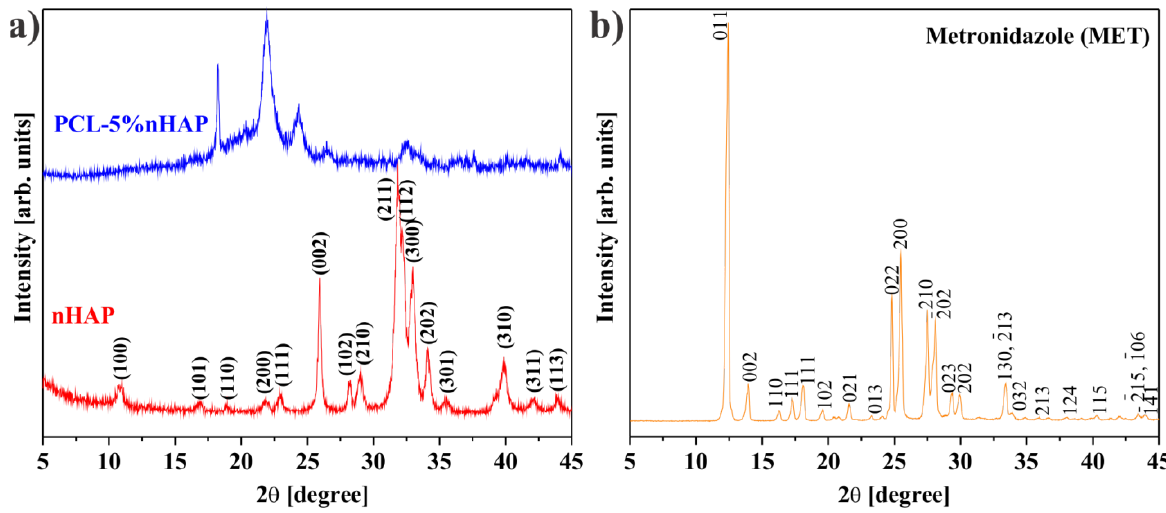
Figure 1. XRD patterns for ( a ) nano-hydroxyapatite (nHAP) and ( b ) metronidazole (MET).